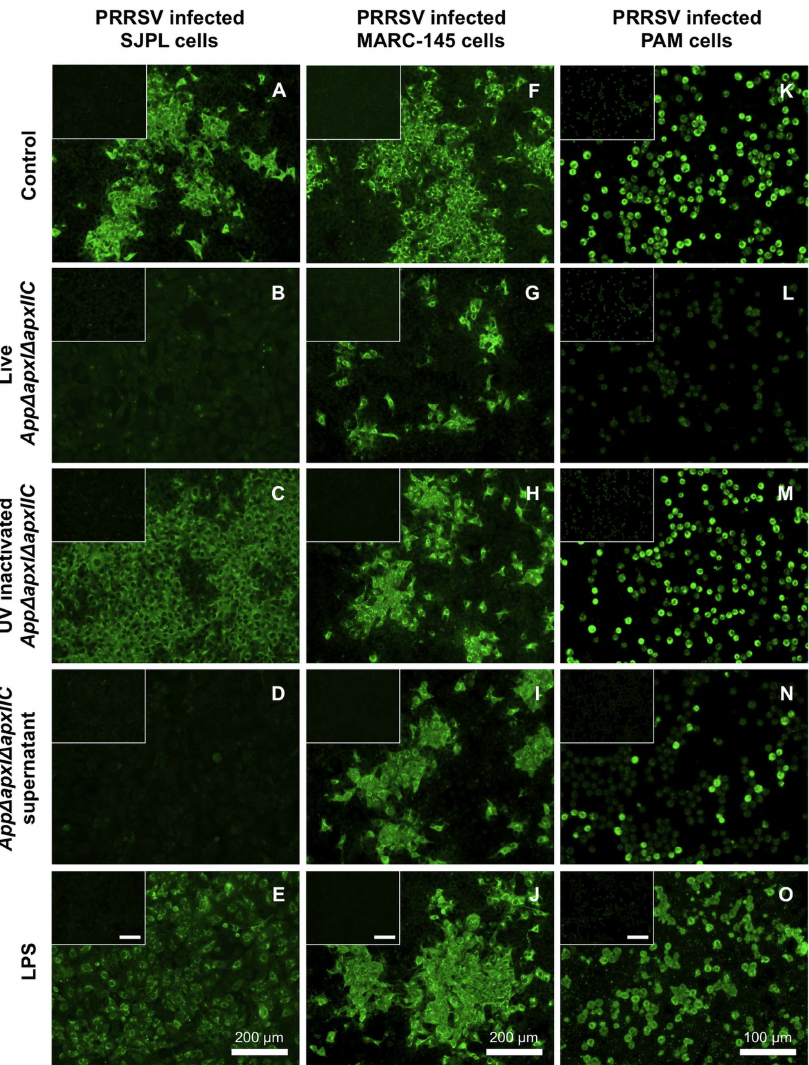
Figure 3. PRRSV antigen detection in SJPL, MARC-145 and PAM cells co-infected with App D apxI D apxIIC . PRRSV N protein revealed by IFA in SJPL (A–E), MARC-145 (F–J) and PAM cells (K–O) were infected with PRRSV at an MOI of 0.5 for 4 hours (A, F and K) then co-infected with live App D apxI D apxIIC at an MOI of 10 (B, G and L), or with UV inactivated App D apxI D apxIIC at an MOI of 10 (C, H and M), or with App D apxI D apxIIC supernatant (D, I and N) or treated with LPS 4 m g/ml (E, J and O) for 48 hours. Inserts are negative control where cells were not infected with PRRSV. White scale bar represents 200 m m for SJPL and MARC-145 cells, and 100 m m for PAM cells. Pictures were taken at 100X magnification for SJPL and MARC-145 cells, and 200X for PAM